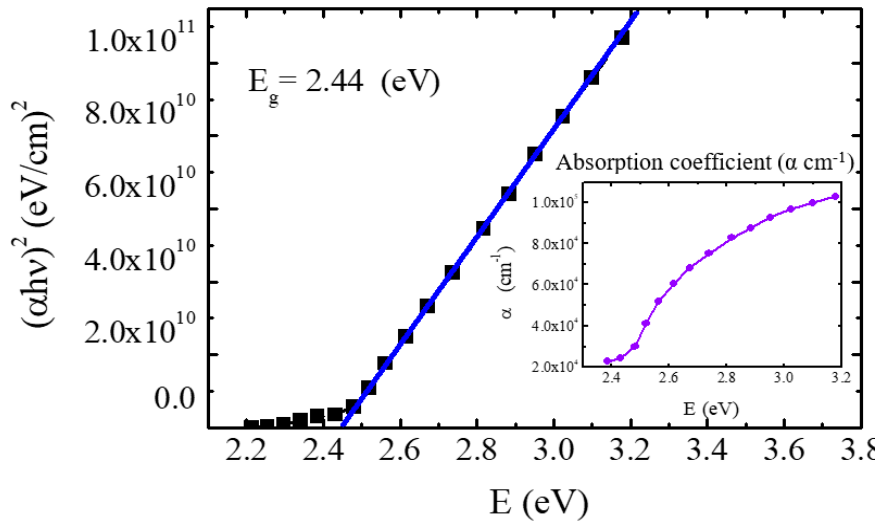
Figure 8. The relation between ( α h ν ) 2 and photon energy (h ν ) for CdS films.